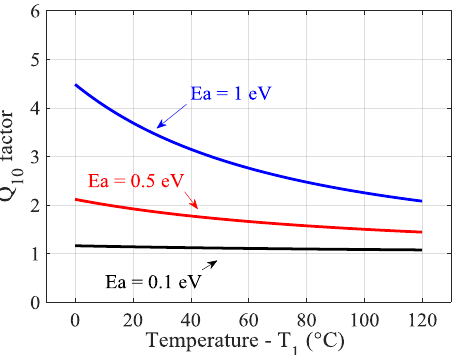
Figure 1. Q 10 factor as a function of temperature T 1 and activation energy E a .